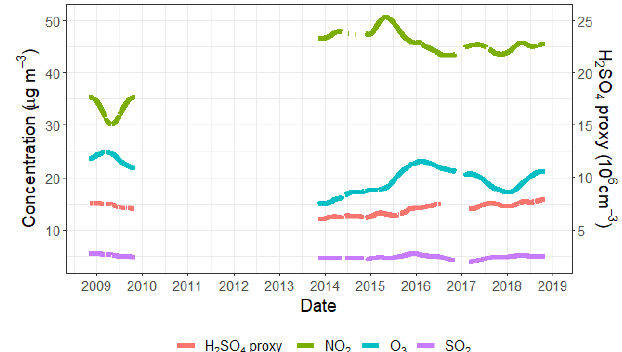
Figure 2. Statistical time trends of gas-phase H 2 SO 4 proxy, SO 2 , O 3 and NO 2 derived by DLM over the decennial